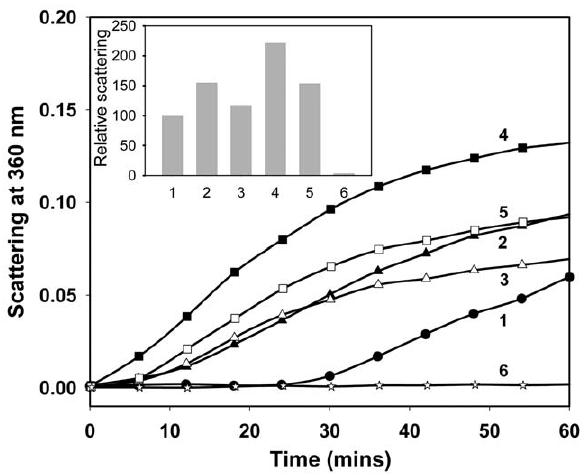
Figure 6. The a A-(66-80) peptide functions as an anti- chaperone. The effect of a A-(66-80) peptide on the chaperone activity